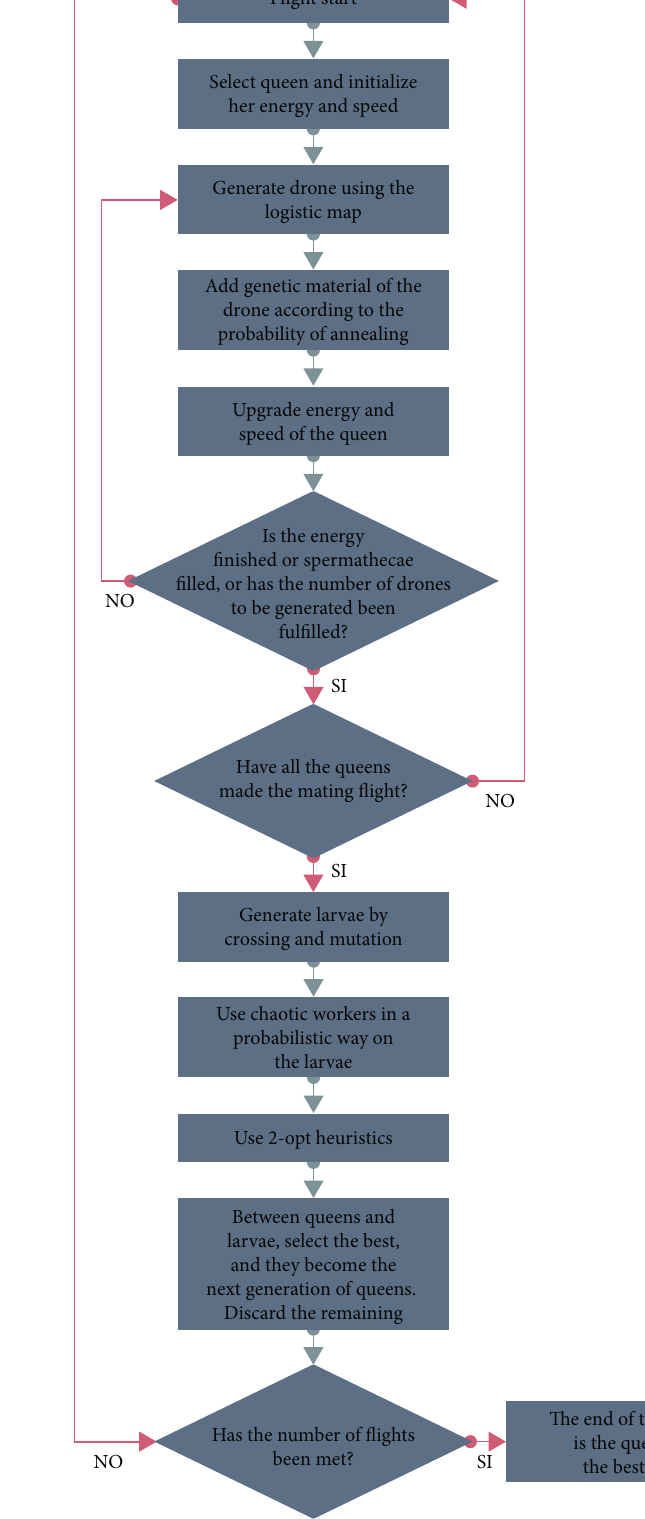
Figure 4: Chaotic MBO algorithm flow